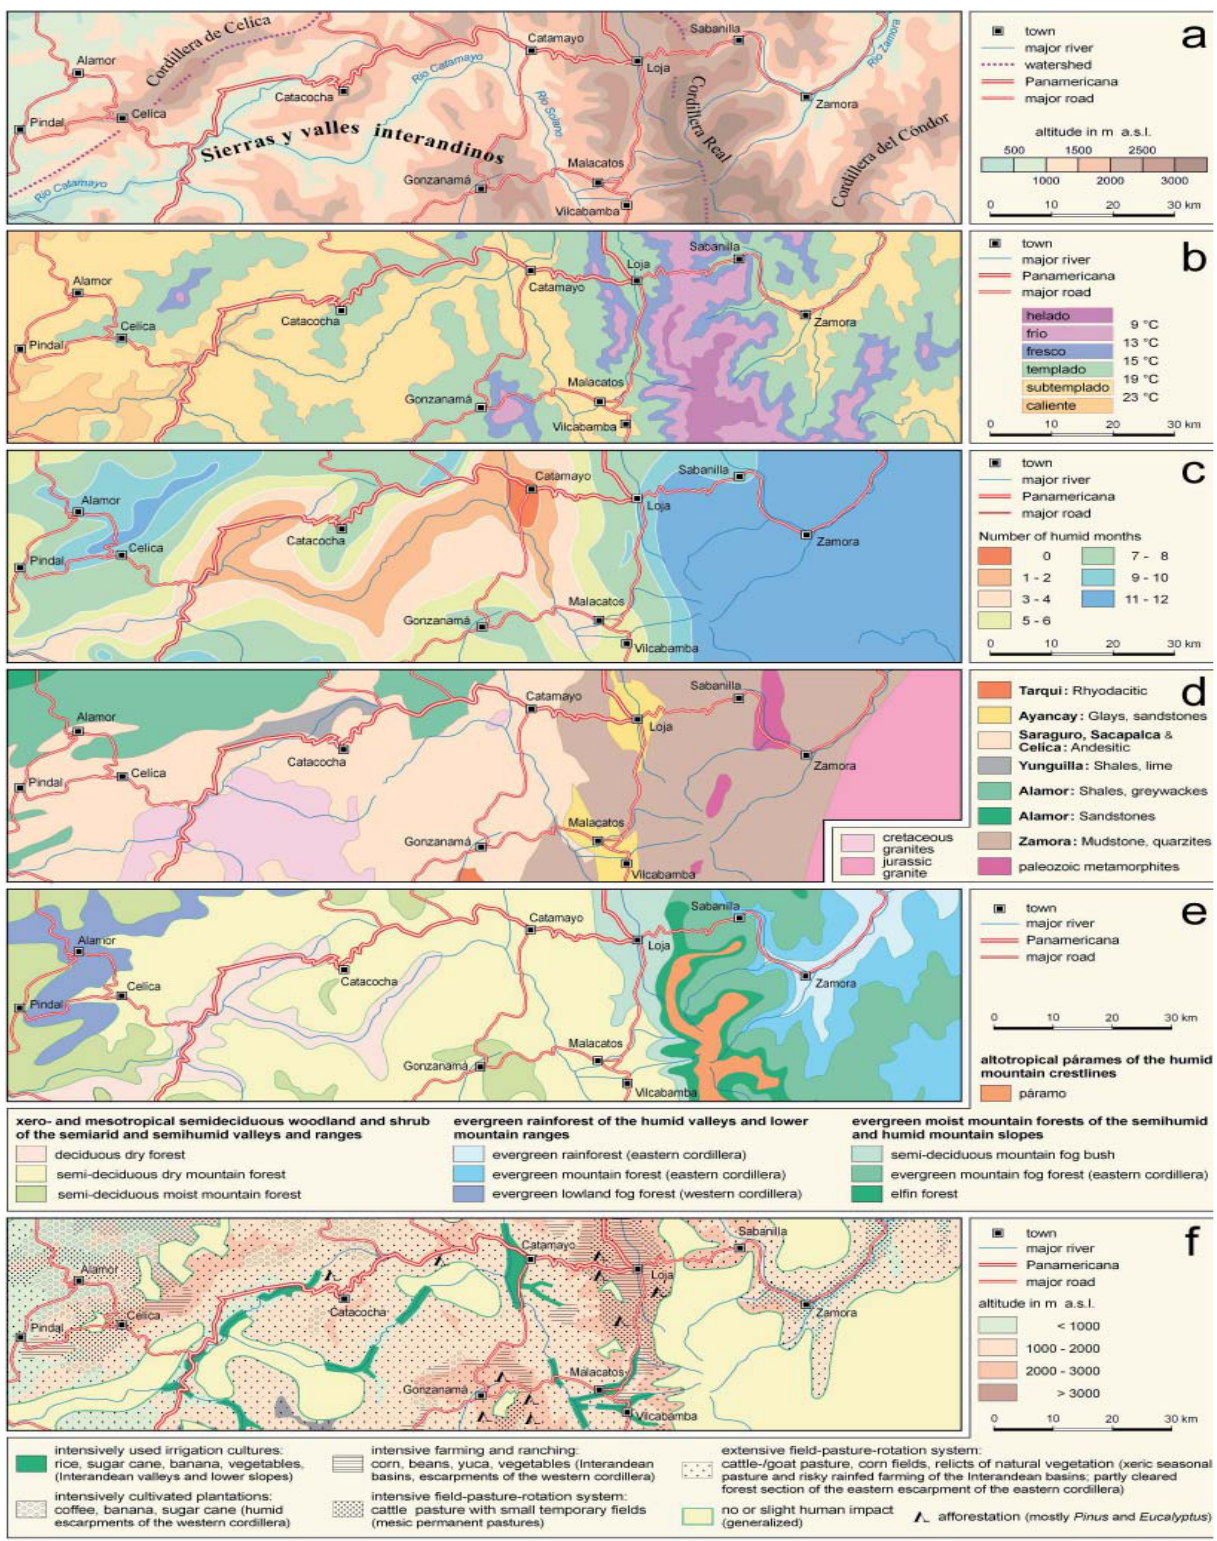
Figure 9: Overview of various ecological components generating and reflecting, respectively, the high “geodiver- sity” of the research area east and west of the Cordillera Real: (a) orography, (b) temperature belts, (c) number of humid months, (d) petrography, (e) natural vegetation, (f) land use. Source: (a-c) and (e-f) M. Richter 2003, modi- fied; (d) kindly provided by F.